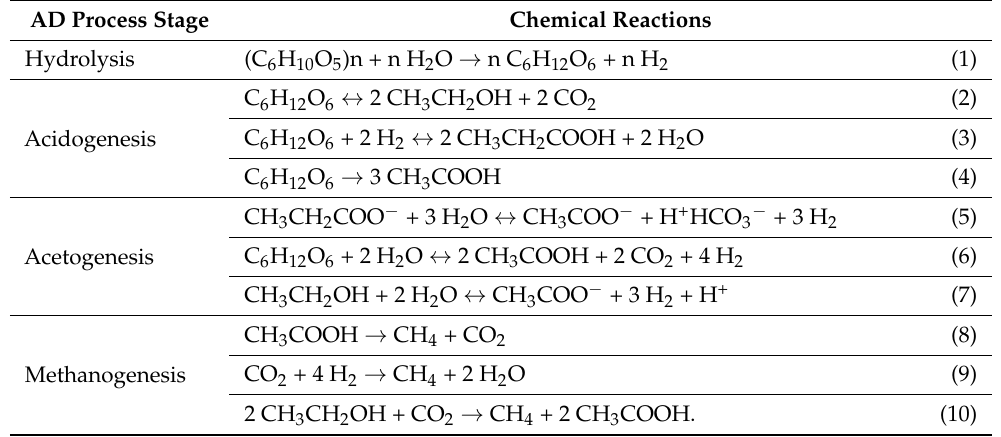
Figure 4. Anaerobic digestion process phases (modified to [51]). Table 2. Principal reactions in the AD process (according to [58]).